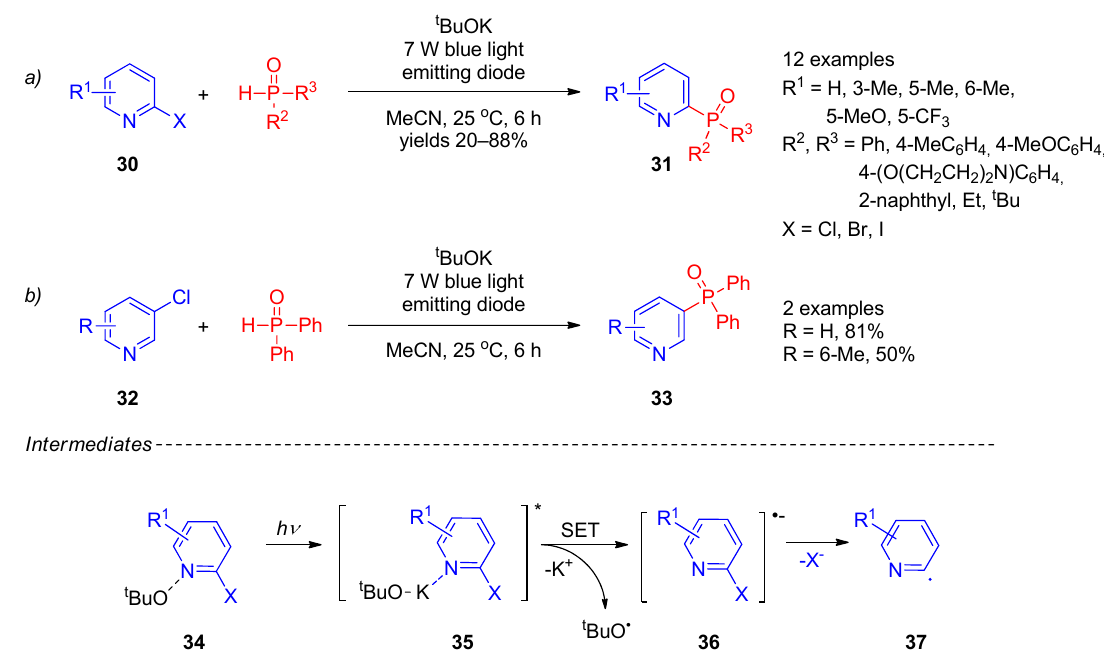
Scheme 6. Photocatalytic phosphorylation of halopyridines: ( a ) Synthesis of 2-phosphine oxide-substituted pyridines; ( b ) Synthesis of 3-phosphine oxide-substituted pyridines. In 2019, the photocatalytic radical reaction of pyridylazo sulfones 38 with